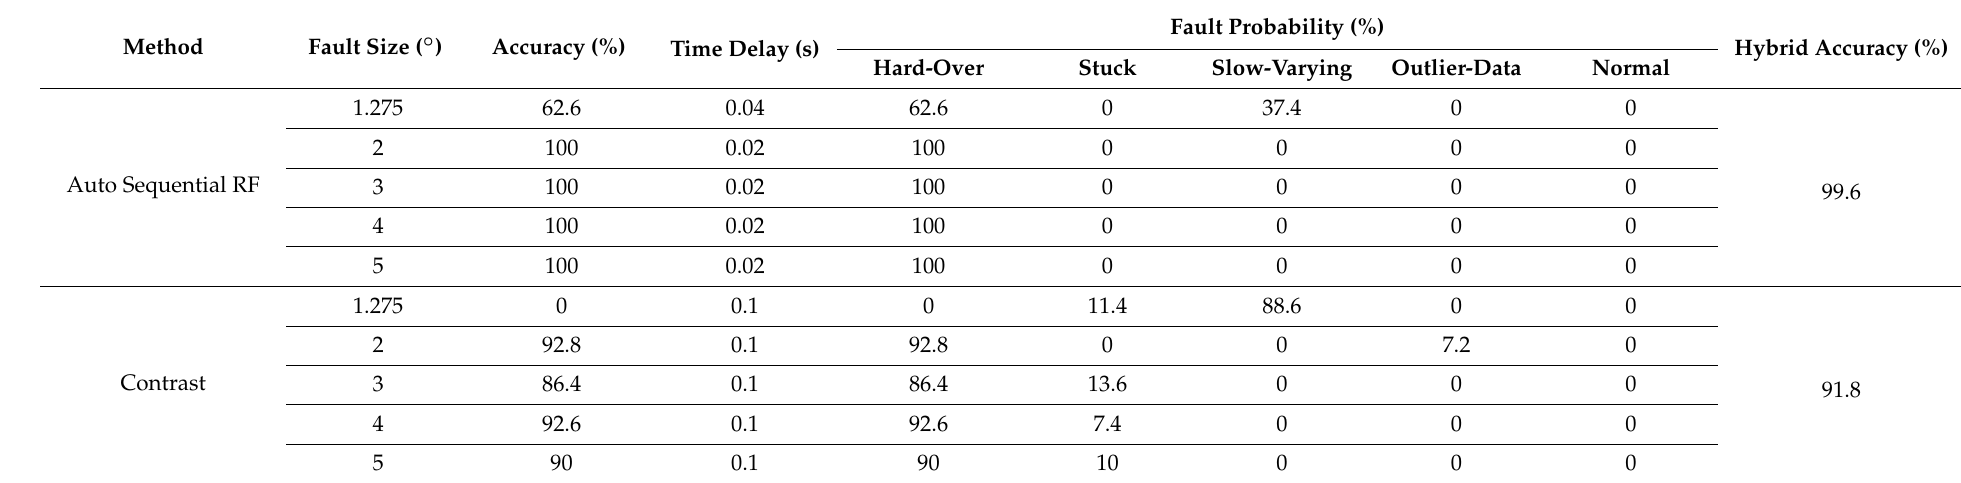
Table 5. Real-time fault diagnosis result of the hard-over